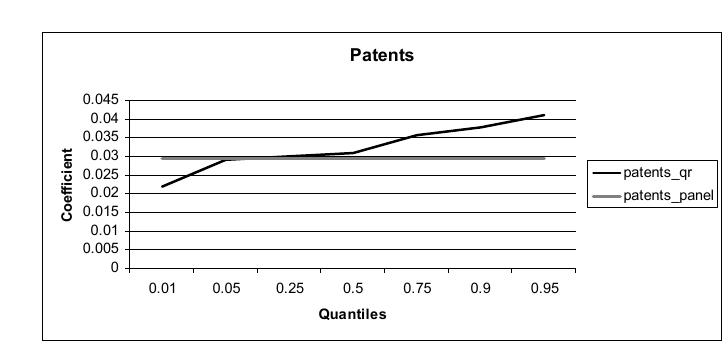
Figure 6 – Quantile Regressions versus Panel Regression estimates: Patents Registered.